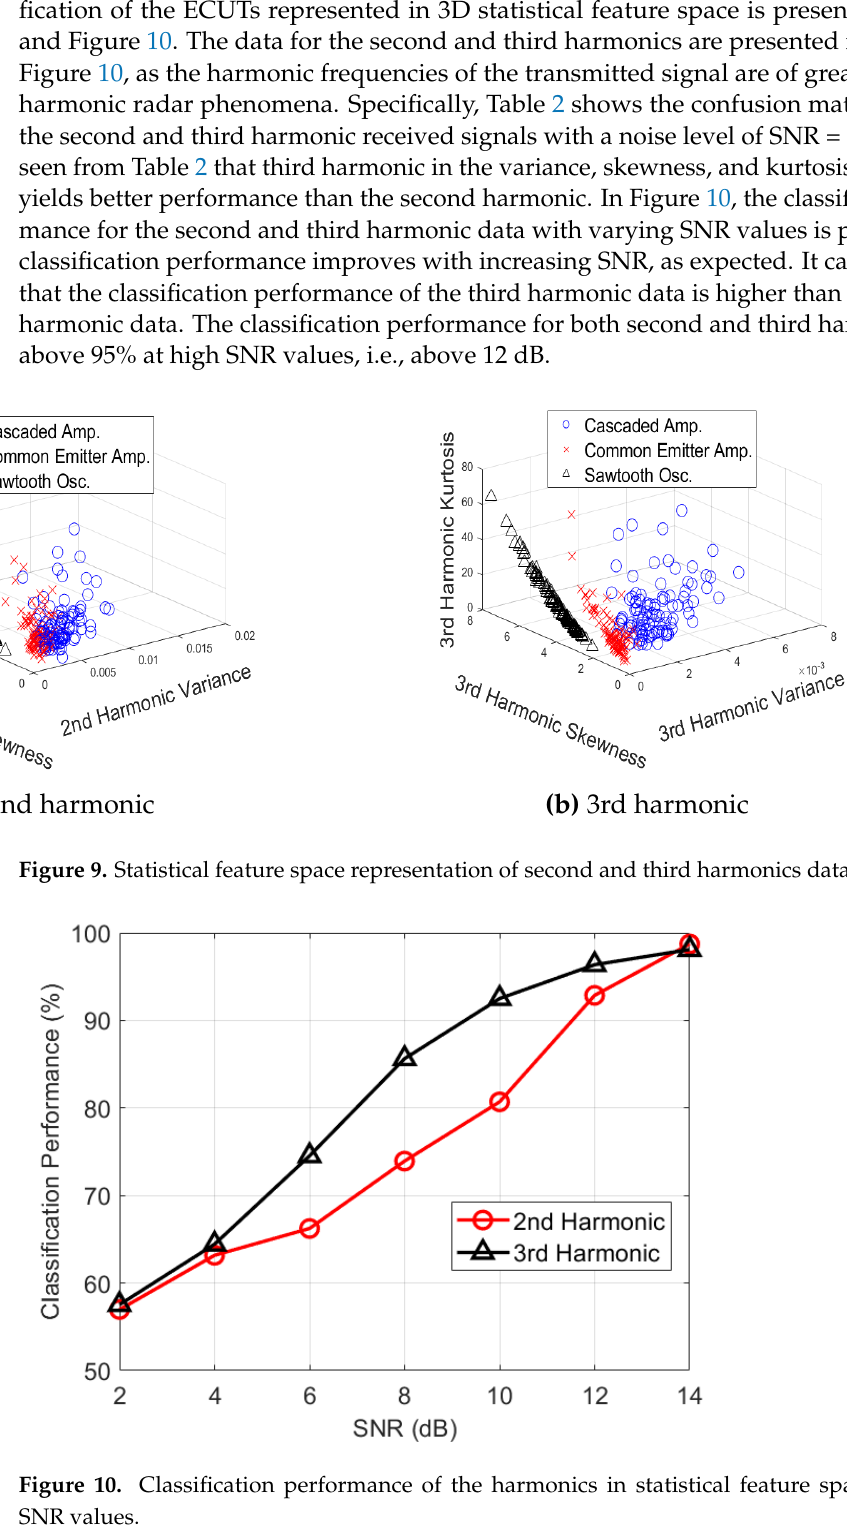
Figure 10. Classification performance of the harmonics in statistical feature space for varying SNR values.